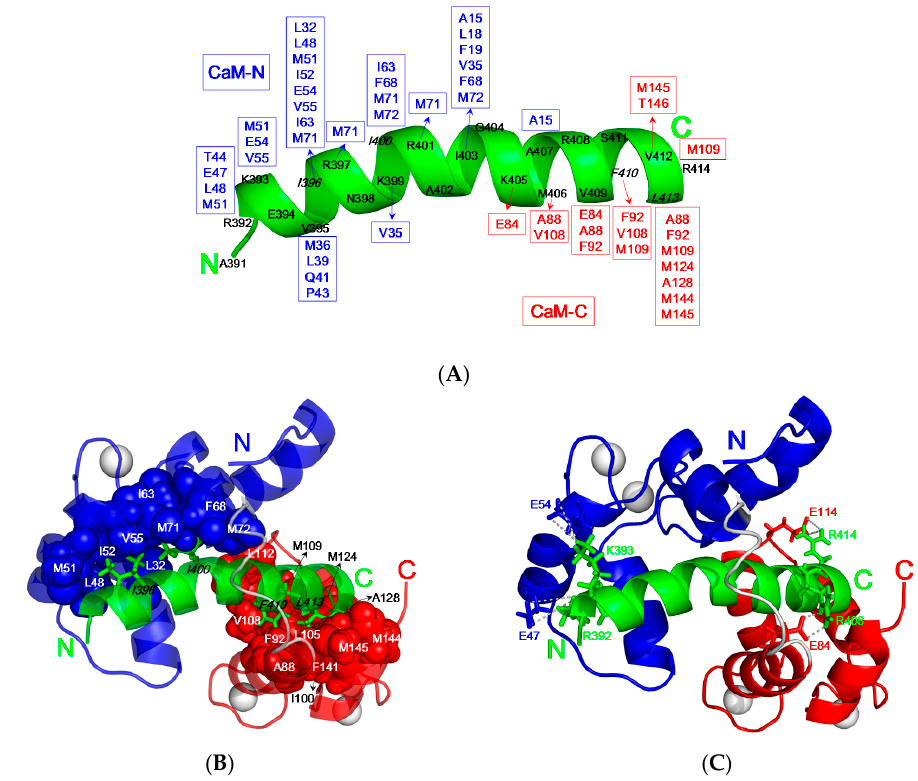
Figure 6. Intermolecular interactions between CaM and CaNp. ( A ) Summary of the observed NOEs between CaM and CaNp. CaNp is shown as a green helical ribbon. Interacting residues in N-domain and C-domain of CaM are labeled in blue and red, respectively; ( B ) The hydrophobic interactions between CaM and CaNp. Two intermolecular hydrophobic clusters were found in the complex of CaM/CaNp. Bulky side chains of Ile 396 and Ile 400 of CaNp (shown in green sticks) anchored in the hydrophobic pocket of N-domain of CaM (shown in blue spheres). Bulky side chains of Phe 410 , and Leu 413 of CaNp (shown in green stick) anchored in the hydrophobic pocket of C-domain of CaM (shown in red spheres); ( C ) The potential electrostatic interactions between the negatively charged residues of CaM (Glu 47 , Glu 54 , Glu 84 , and Glu 114 ) and the positively charged residues of CaNp (Arg 392 , Lys 393 , Arg 408 , and Arg 414 ) are shown.